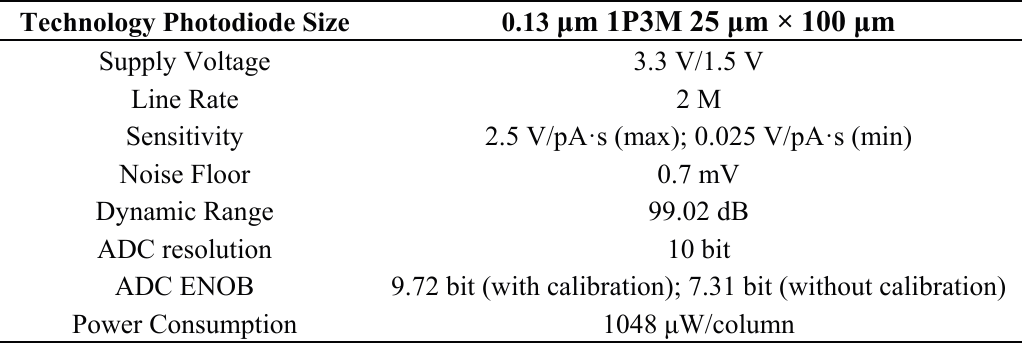
Table 3. Summary of the sensor